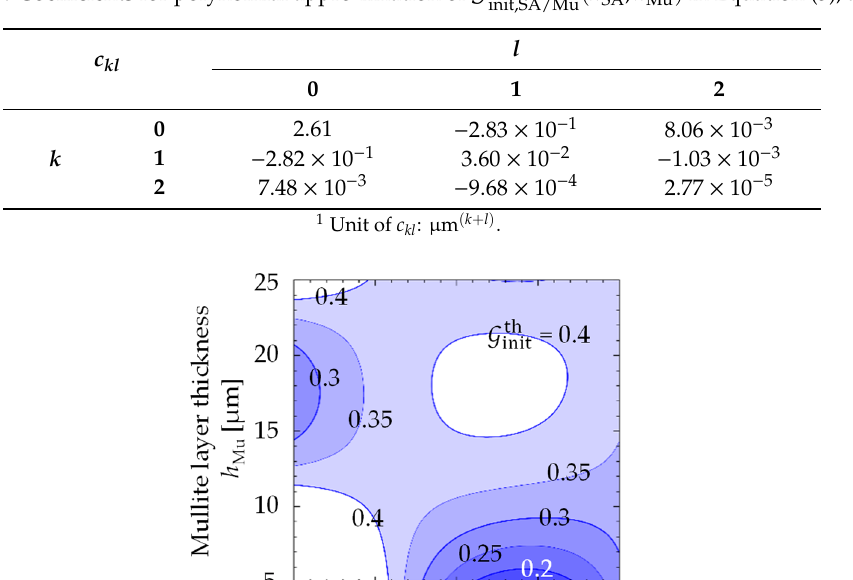
1 . ) in Equation (5), c ( h SA , h Mu kl init,SA/Mu